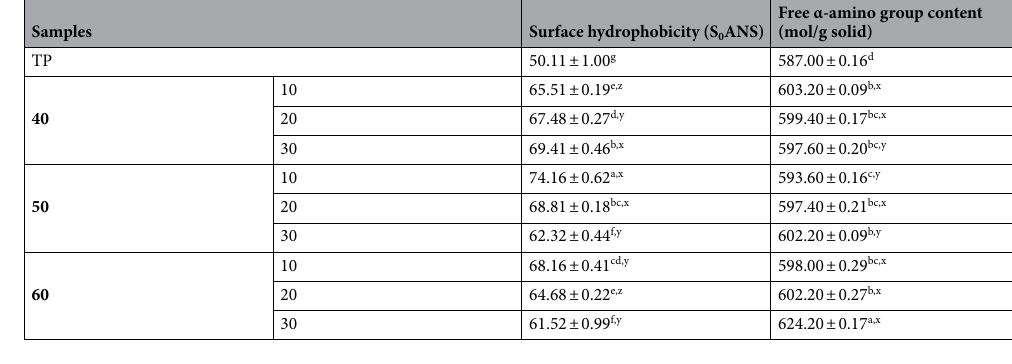
Table 2. Surface hydrophobicity and free alpha-amino group content of protein extracted from Bombay locust by ultrasound-assisted process under different conditions. Data are expressed as mean ± standard deviation (n = 3). TP, Typical extraction process (without ultrasound-assisted process). 40, 50, 60; Amplitudes of ultrasound-assisted process (%). 10, 20, 30; Ultrasonication times (min). a,b,c … indicated significant differences of data in the same column ( P < 0.05). x,y,z indicated significant differences of data comparing in the same ultrasonication time ( P <